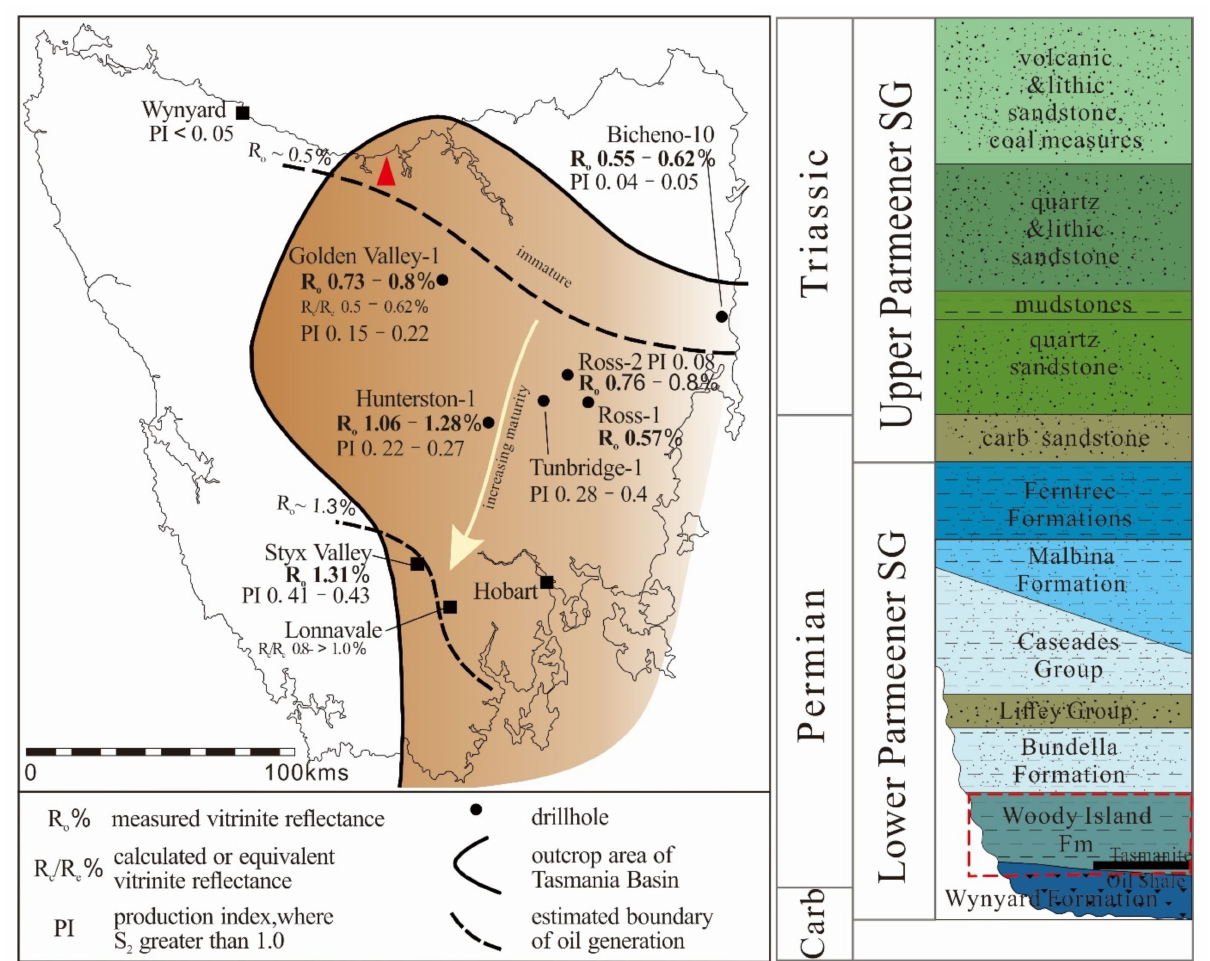
Figure 1. The sampling location and maturity distribution of the Tasmanite shales (modified from Reid and Burrett